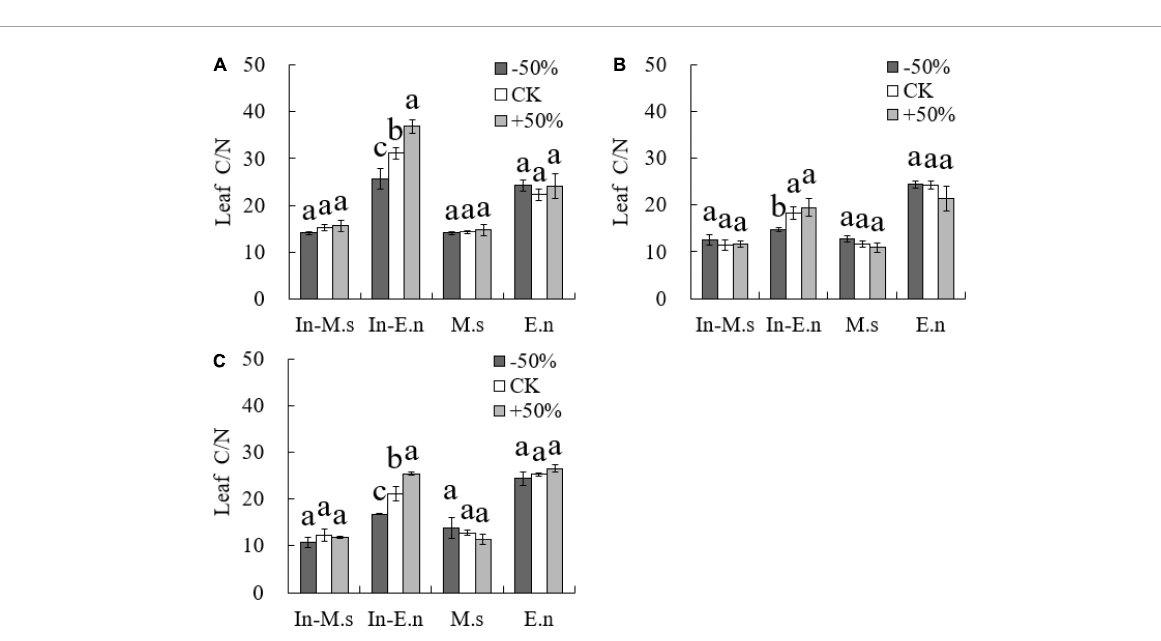
FIGURE7 Effects of water on nitrogen use efficiency of forages ( A: 2015; B: 2016; C: 2017). Different lowercase letters show significant differences under different water levels ( P <